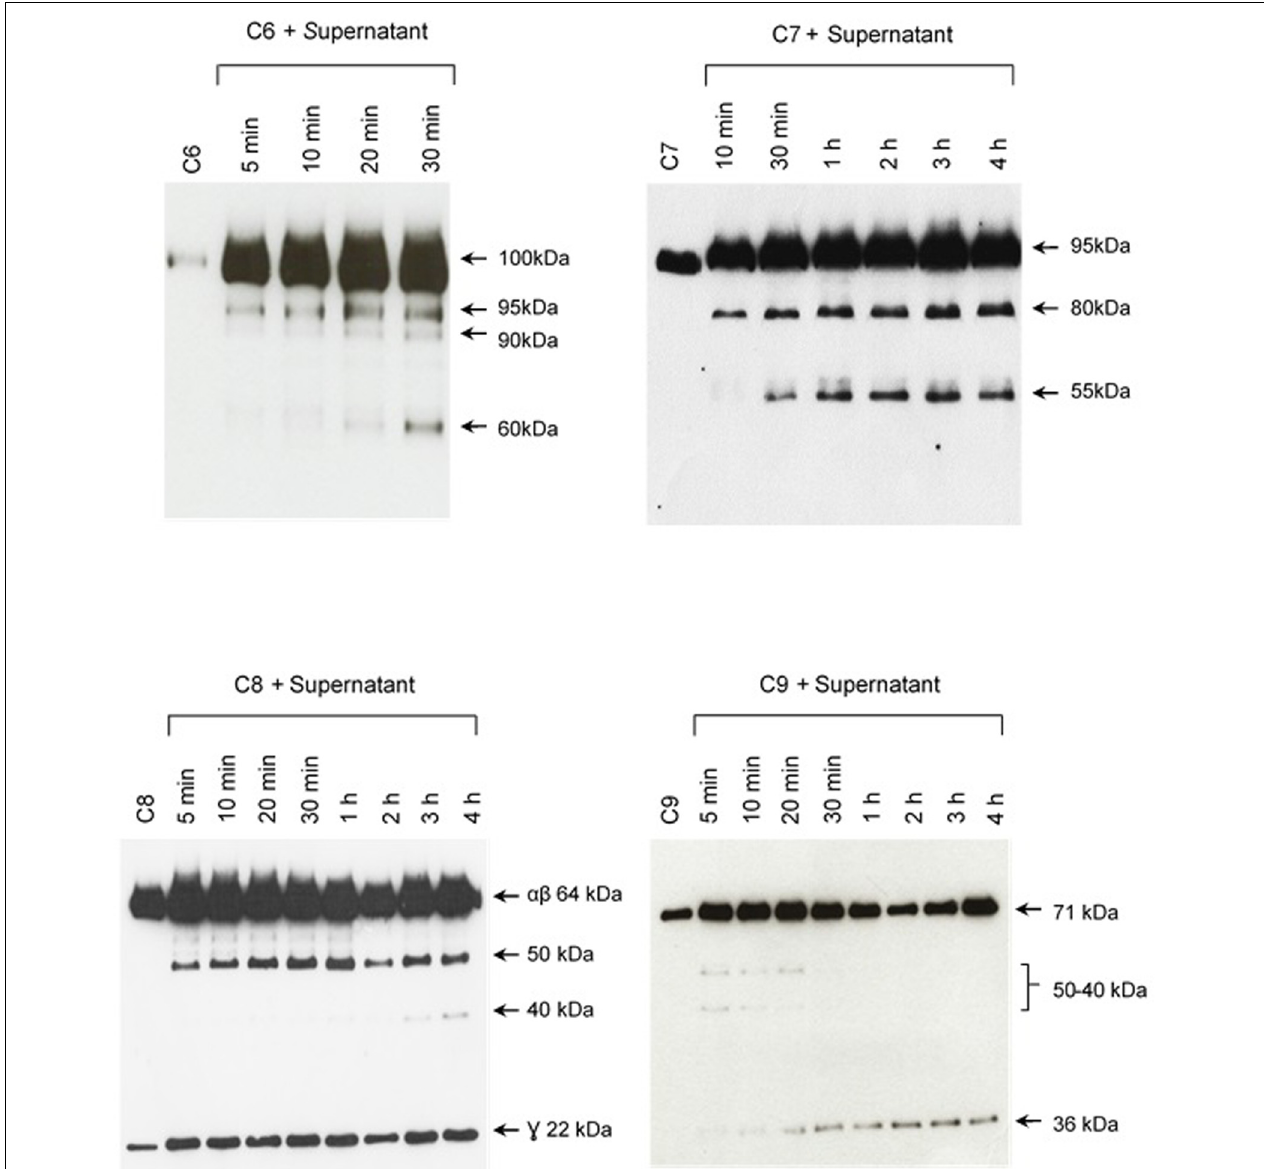
FIGURE 3 | The cleavage of MAC proteins by leptospiral proteases is time-dependent. Pathogenic L. interrogans serovar Kennewiki strain Fromm was allowed to secrete proteases for 4 h at 37 ◦ C. The supernatant was collected and incubated with C6, C7, C8, or C9 for increasing times (5 min to 4 h) at 37 ◦ C. The cleavages were analyzed by Western blot with polyclonal antibodies against the Complement